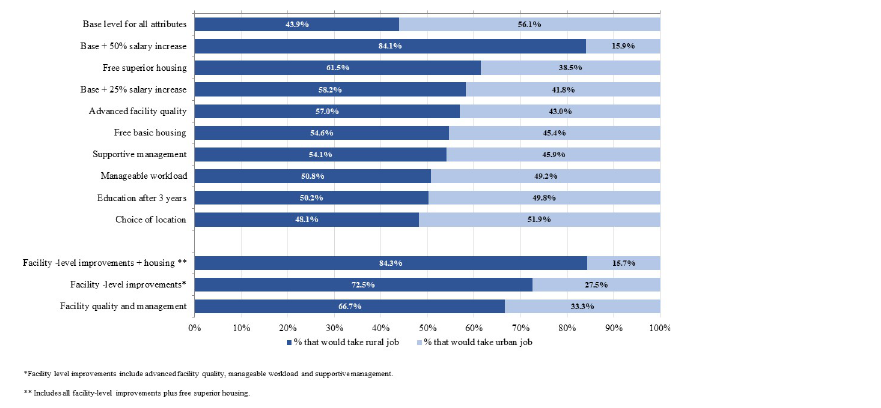
Fig 1. Expected rural and urban job uptake with job